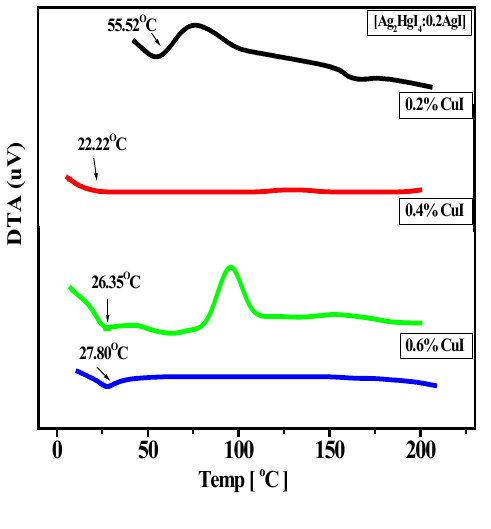
Figure 7. Differential thermal analysis (DTA) curves for mixed composite systems [Ag amount of CuI.